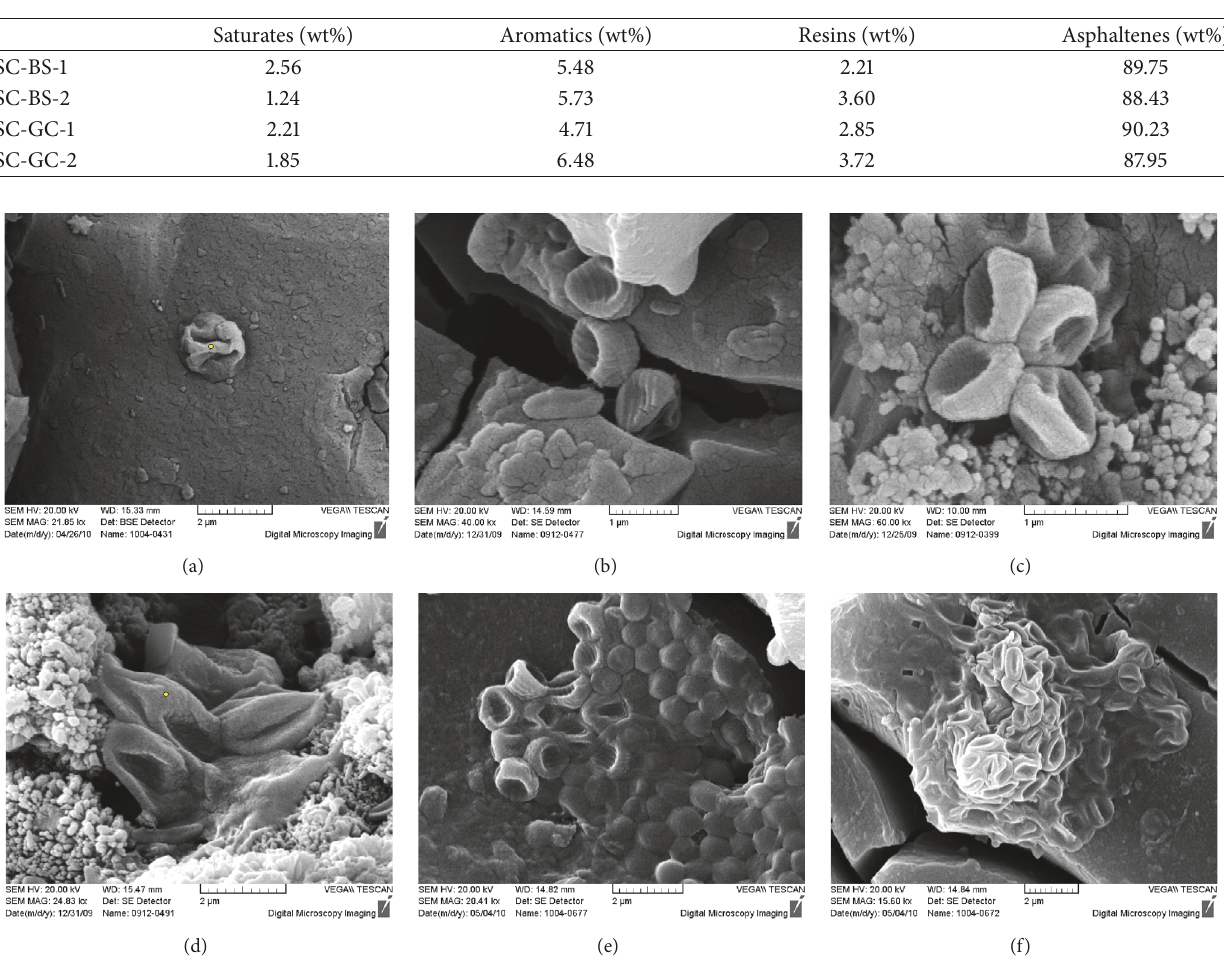
Figure 5: SEM photomicrographs of the spherical bacteria fossils and the colonial structures. EDS data of (a) and (d) were showed in Table 1.